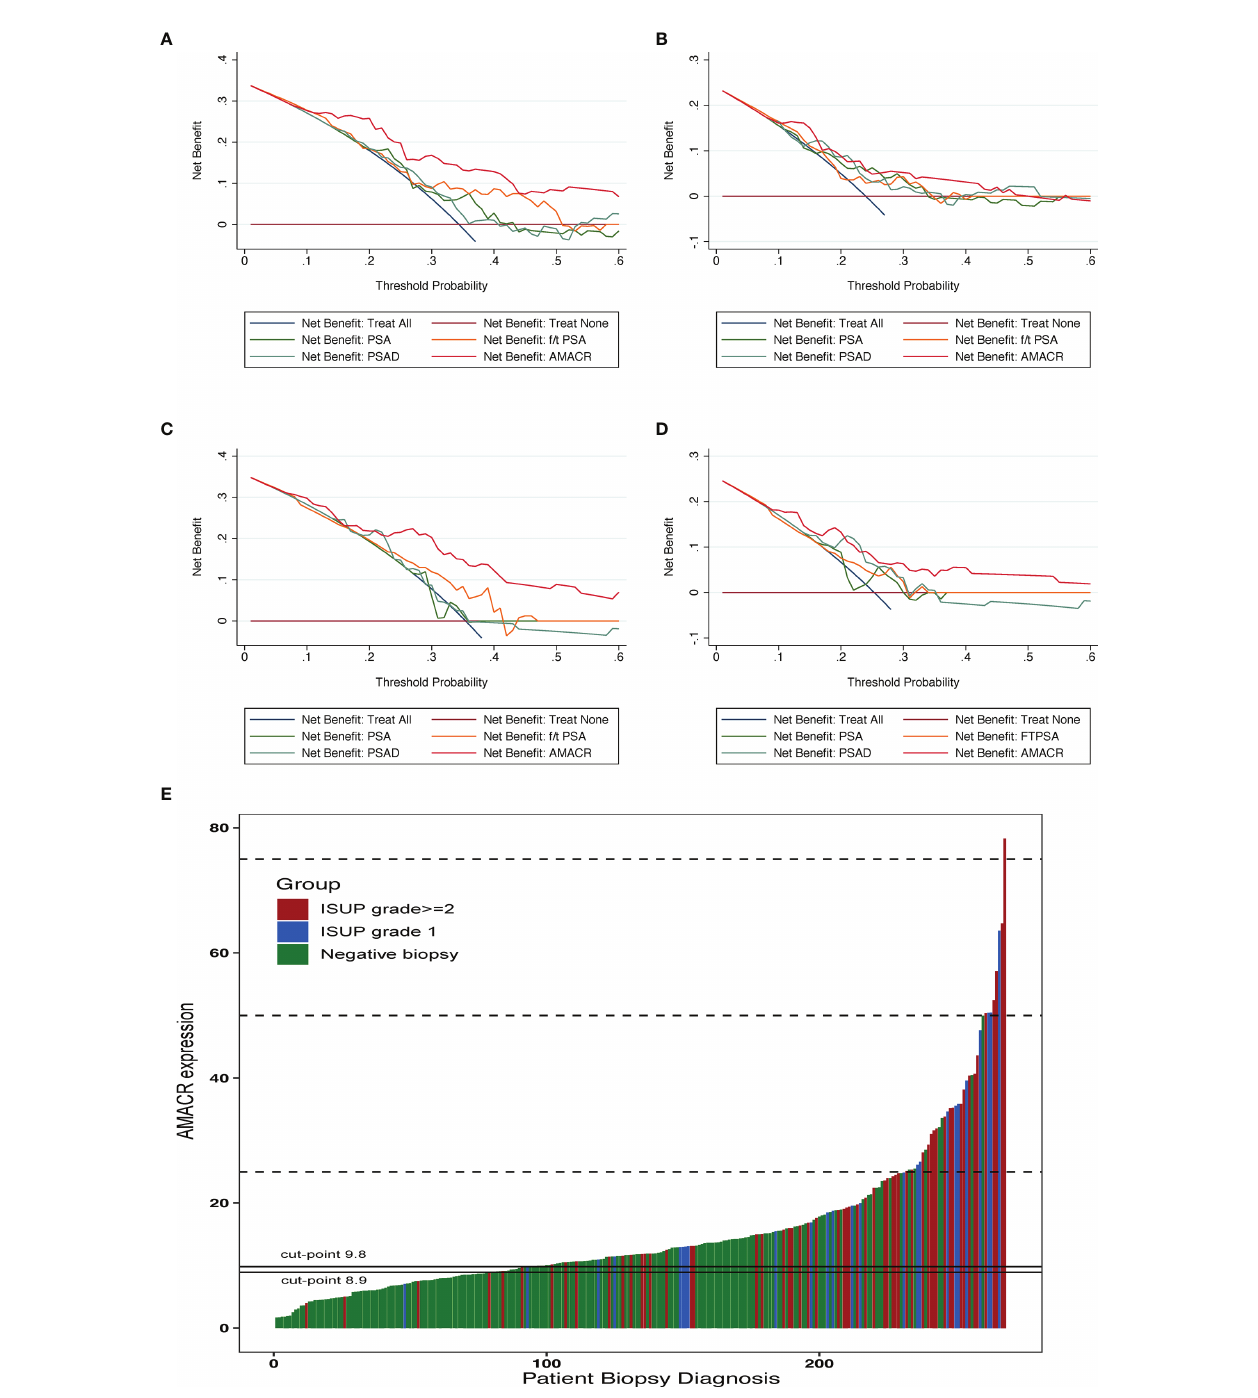
FIGURE 3 | Clinical application of the urine exosomal AMACR. The DCA indicates that urine AMACR has a higher net bene fi t across a threshold of 20% – 50% probabilities for diagnosing PCa (A, C) and csPCa (B, D) in two cohorts. (E) Waterfall plot of the urine AMACR in relation to prostate biopsy results ( n = 272). Red bar indicates the ISUP grade ≥ 2 tumors (GS ≥ 7); the blue one indicates the ISUP grade 1 tumors (GS = 6); the green one indicates the negative biopsies. Two horizontal lines represent the cutoff points of 9.8 at a sensitivity of 90% and 8.9 at a sensitivity of